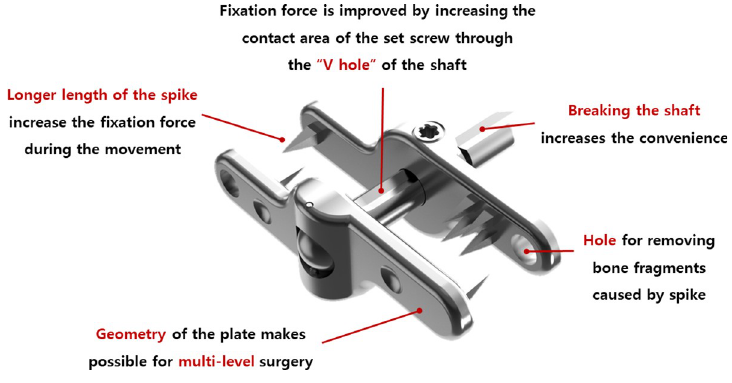
Fig 6. Features of the TAU